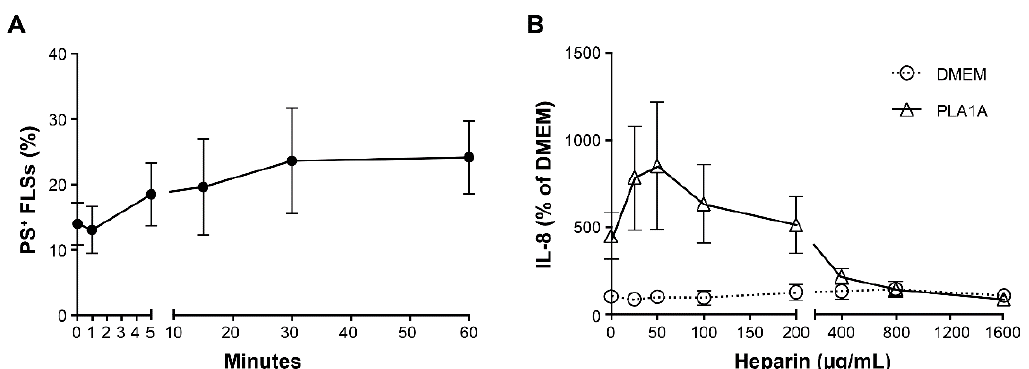
Figure 4. Exposure of phosphatidylserine (PS) and effects of PLA1A on activated human primary FLSs. ( A ) Human primary FLSs were activated with 100 ng/mL TNF for 1, 5, 15, 30, and 60 min. Surface exposure of PS on collected cells were stained with propidium iodide (PI) and FITC Annexin V and examined using flow cytometry. FITC Annexin V-positive and PI-negative cells were considered as PS-positive viable cells. ( B ) Human primary FLSs were treated with 0.2 µ g/mL recombinant PLA1A in the absence or presence of heparin at concentrations of 25, 50, 100, 200, 400, 800, and 1600 µ g/mL for 24 h. Heparin was added to cell culture 30 min prior to PLA1A. The amounts of IL-8 released in the supernatants were monitored using ELISA. IL-8 produced by FLSs cultured in serum-free DMEM was 5.37 ± 1.43 pg/mL, and for each experiment, basal IL-8 production was set at 100% for data normalization. The data were the means ± SE from three experiments.